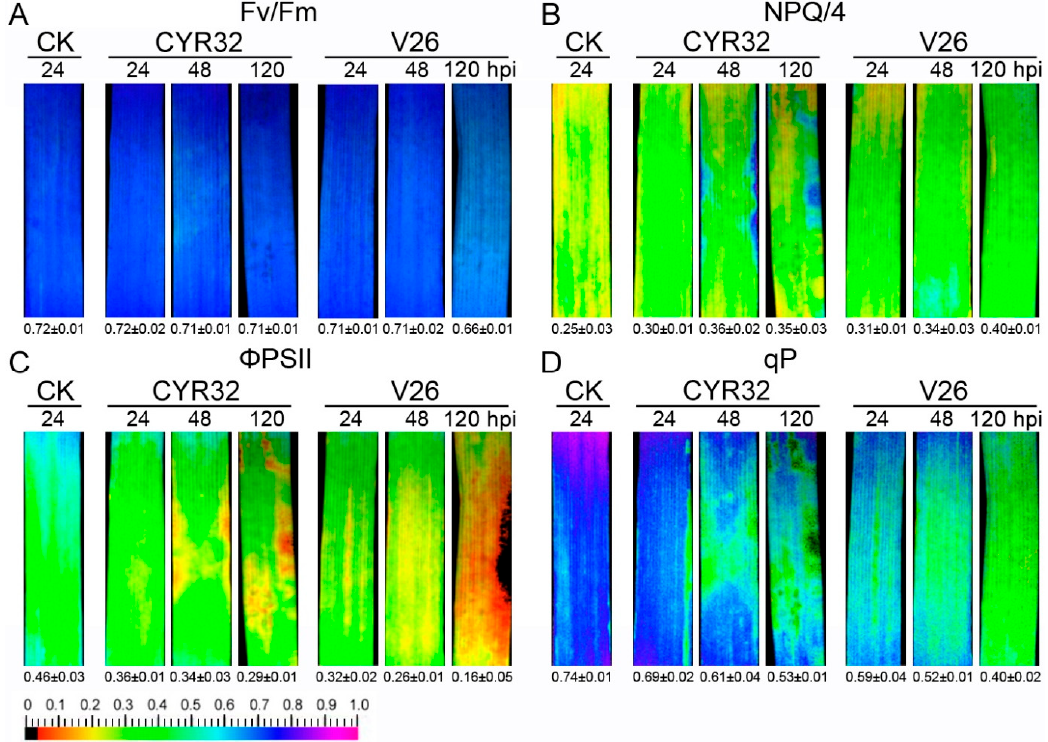
Figure 7. Chlorophyll fluorescence parameters in wheat cultivar CM42 inoculated with CYR32 and V26. Fv/Fm, maximum efficiency of PSII photochemistry ( A ). NPQ, non-photochemical quenching ( B